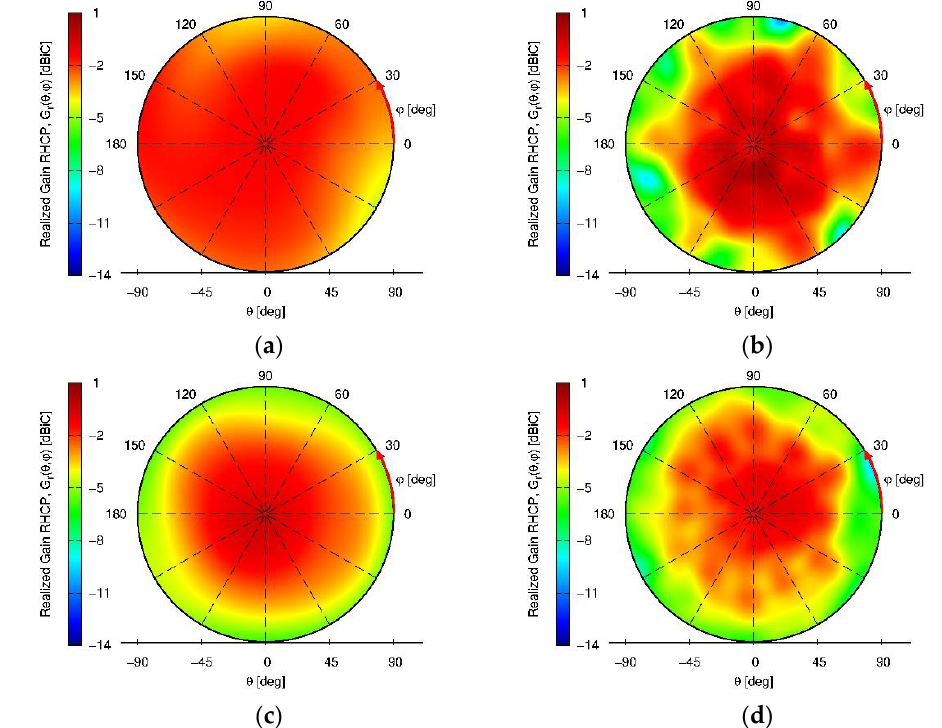
Figure 15. Measured RHCP and LHCP realized gain patterns of the miniaturized GNSS array without vertical choke rings standalone or installed on a hex-rotor UAV with installation height of 110 mm. ( a ) L5/E5a, standalone; ( b ) L5/E5a, on UAV h = 110 mm; ( c ) L1/E1 standalone; ( d ) L1/E1, on UAV h = 110 mm.